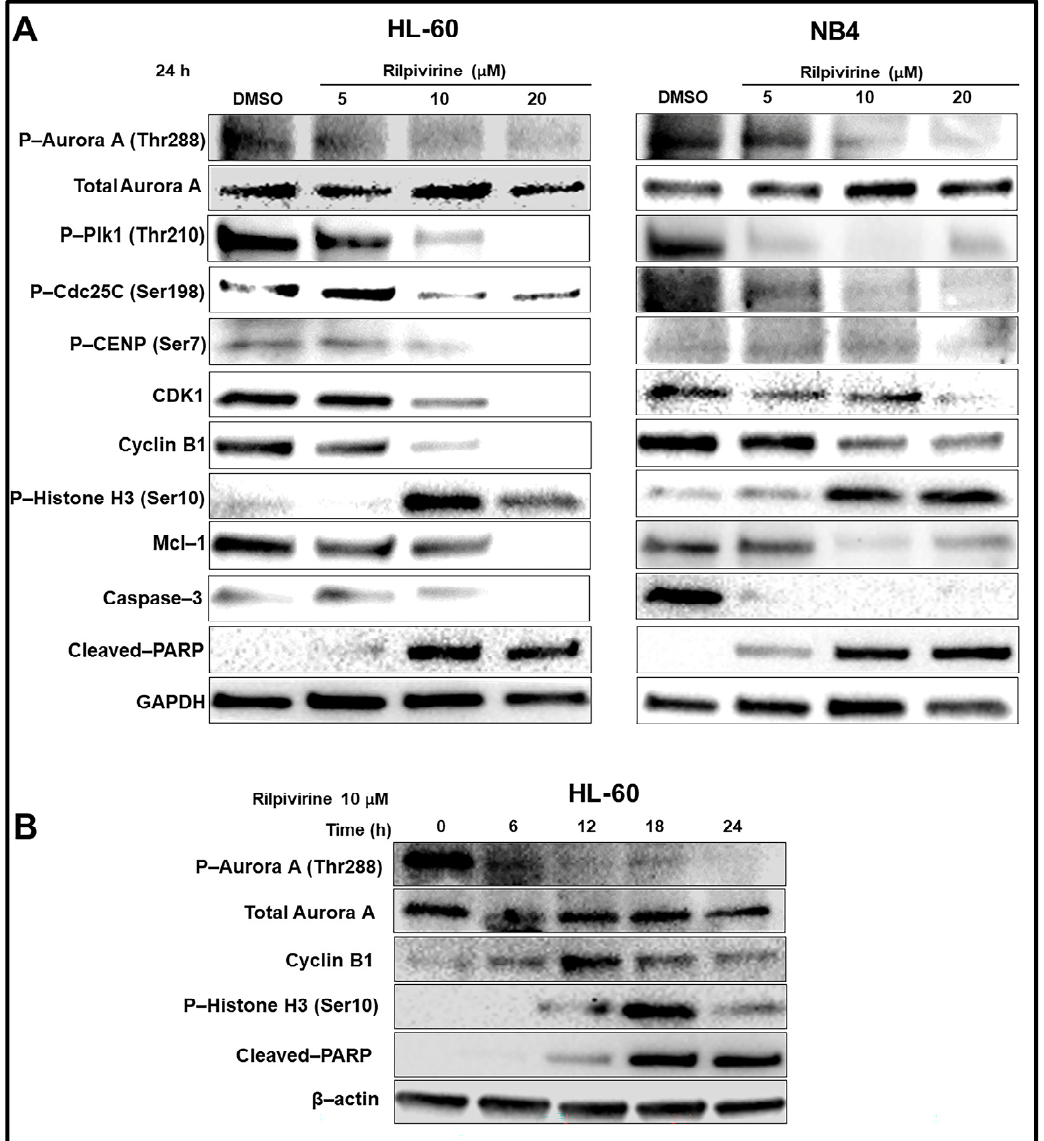
Figure 5. Mechanisms of anti-leukaemic action of rilpivirine. ( A ) Western blot analysis of HL-60 and NB4 cells treated with rilpivirine at indicated concentrations for 24 h. ( B ) Western blot analysis of HL-60 cells treated with 10 µM rilpivirine over different time intervals as indicated. Anti-bodies used are indicated on the left side of each panel, respectively. DMSO diluent is used as a control. GAPDH and β -actin are used as the internal loading controls. The results of at least two independent experiments are presented in the figure.